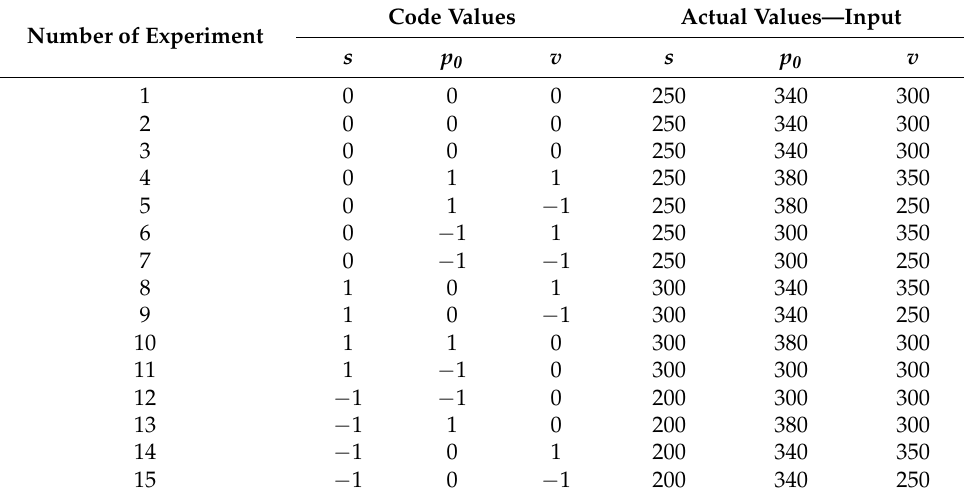
Table 1. Design of Box–Behnken experiment—code values and the corresponding actual values of the process parameters (experimental values).